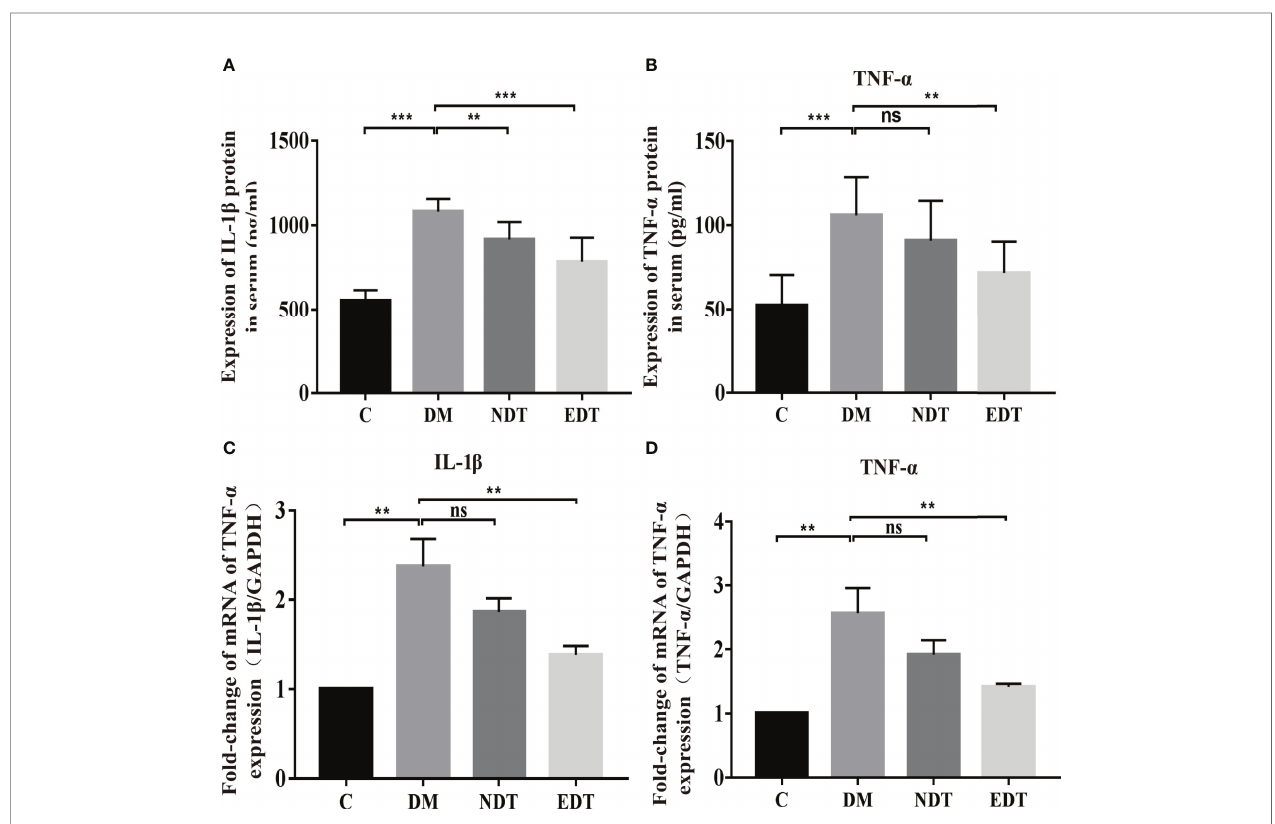
FIGURE 5 | Effects of L. crispatus -pMG36e-mCXCL12 on the expression of pro-in fl ammatory factors at the protein and gene levels in intrauterine adhesion mice with diabetes. Effect of L. crispatus -pMG36e-mCXCL12 on the expression of IL-1 b (A) and TNF- a (B) in the uterine tissue of intrauterine adhesion mice with diabetes at the protein level. Effect of L. crispatus -pMG36e-mCXCL12 on the expression of IL-1 b (C) and TNF- a (D) in the uterine tissue of intrauterine adhesion mice with diabetes at the gene level. C group, Control group; DM group, laparotomy was used to construct a model of intrauterine adhesion mice with diabetes; NDT group was treated with L. crispatus for intrauterine adhesion mice with diabetes; EDT group was treated with L. crispatus -pMG36e-mCXCL12 for intrauterine adhesion mice with diabetes. Unpaired t-test was used for statistical analysis and all data are presented as mean ± standard deviation (SD). ns, P > 0.05; **P < 0.01; ***P <